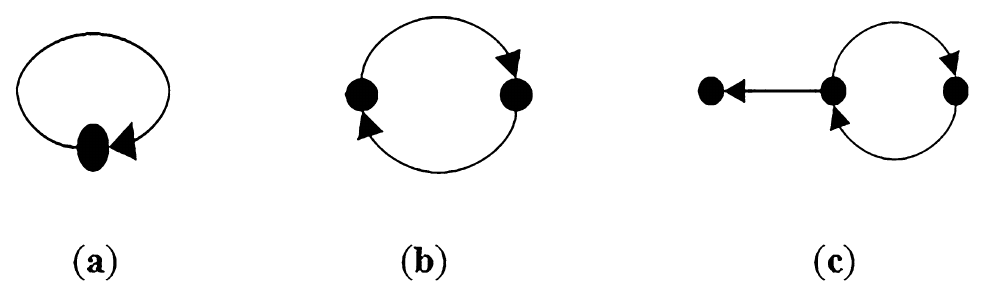
Figure 4. ( a ) A 1-cycle and ACS, ( b ) A 2-cycle and ACS and ( c ) an ACS but not